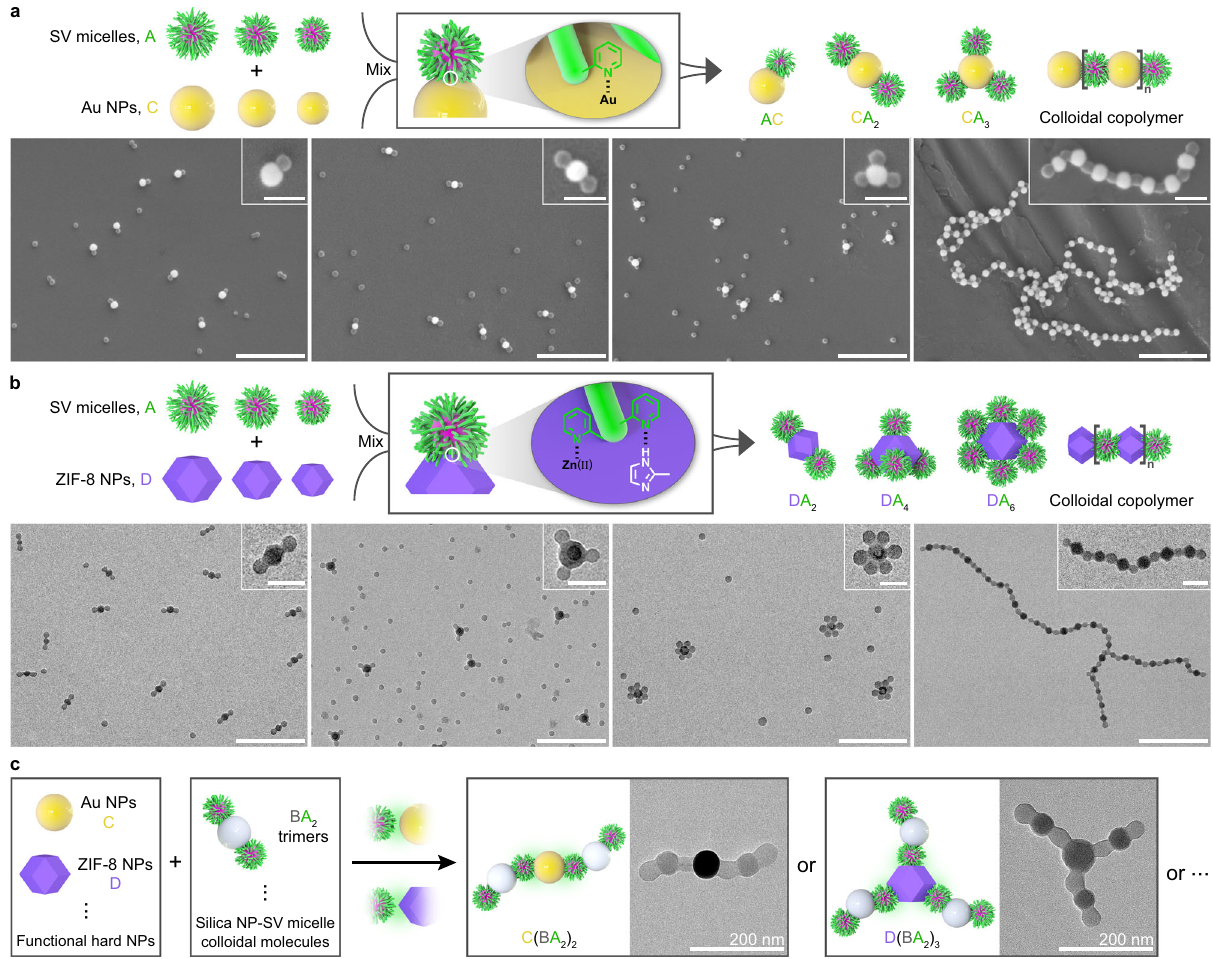
Fig. 4 Tunable co-assembly of SV micelles and various functional hard NPs. A diverse array of hard NPs can be assembled with SV micelles in a controlled manner via noncovalent interactions, such as H-bonding and/or coordination interactions. a Colloidal molecules and copolymers assembled from 47-nm Au NPs and SV micelles. SEM images show resultant structures formed by the association of 47-nm Au NPs with (from left to right) S 2040 V 1590 , S 1520 V 370 , S 460 V 190 , and S 1220 V 440 micelles, respectively. Scale bars = 500 nm; inset scale bars = 100 nm. b Colloidal molecules and copolymers generated from ZIF-8 NPs and SV micelles. TEM images display resultant architectures formed by (from left to right) 53-nm ZIF-8 NPs and S 2090 V 380 micelles, 70-nm ZIF-8 NPs and S 1220 V 440 micelles, 70-nm ZIF-8 NPs and S 1030 V 150 micelles, 53-nm ZIF-8 NPs and S 2090 V 380 micelles, respectively. Scale bars = 500 nm; inset scale bars = 100 nm. c Core-arm-structured multicompartment colloidal conjugates assembled from functional hard NPs (Au NPs and ZIF-8 NPs) and colloidal molecules derived from silica NPs and SV micelles. TEM images present C(BA 2 ) 2 and D(BA 2 ) 3